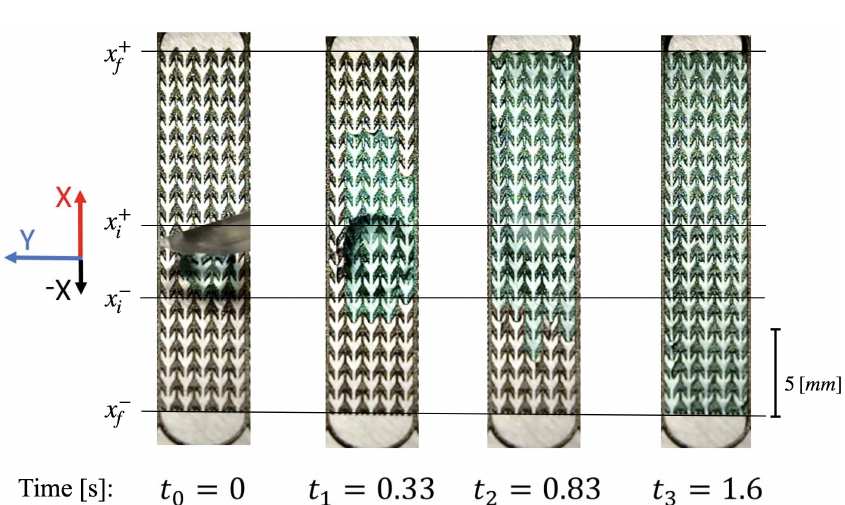
Figure 5. Time evolution of directional drop wicking on structure B. The bottom of the channel appears as white and the top of the structure is dark. Water is colored for better visibility. The first picture at time t 0 present the pipette that places a water drop on B structure. At time t 1 the drop has begun to wick through the channels. At time t 2 , the structure is completely flooded in the positive direction while wicking progress is slower in the negative direction. Finally at time t 3 transport in the negative direction is